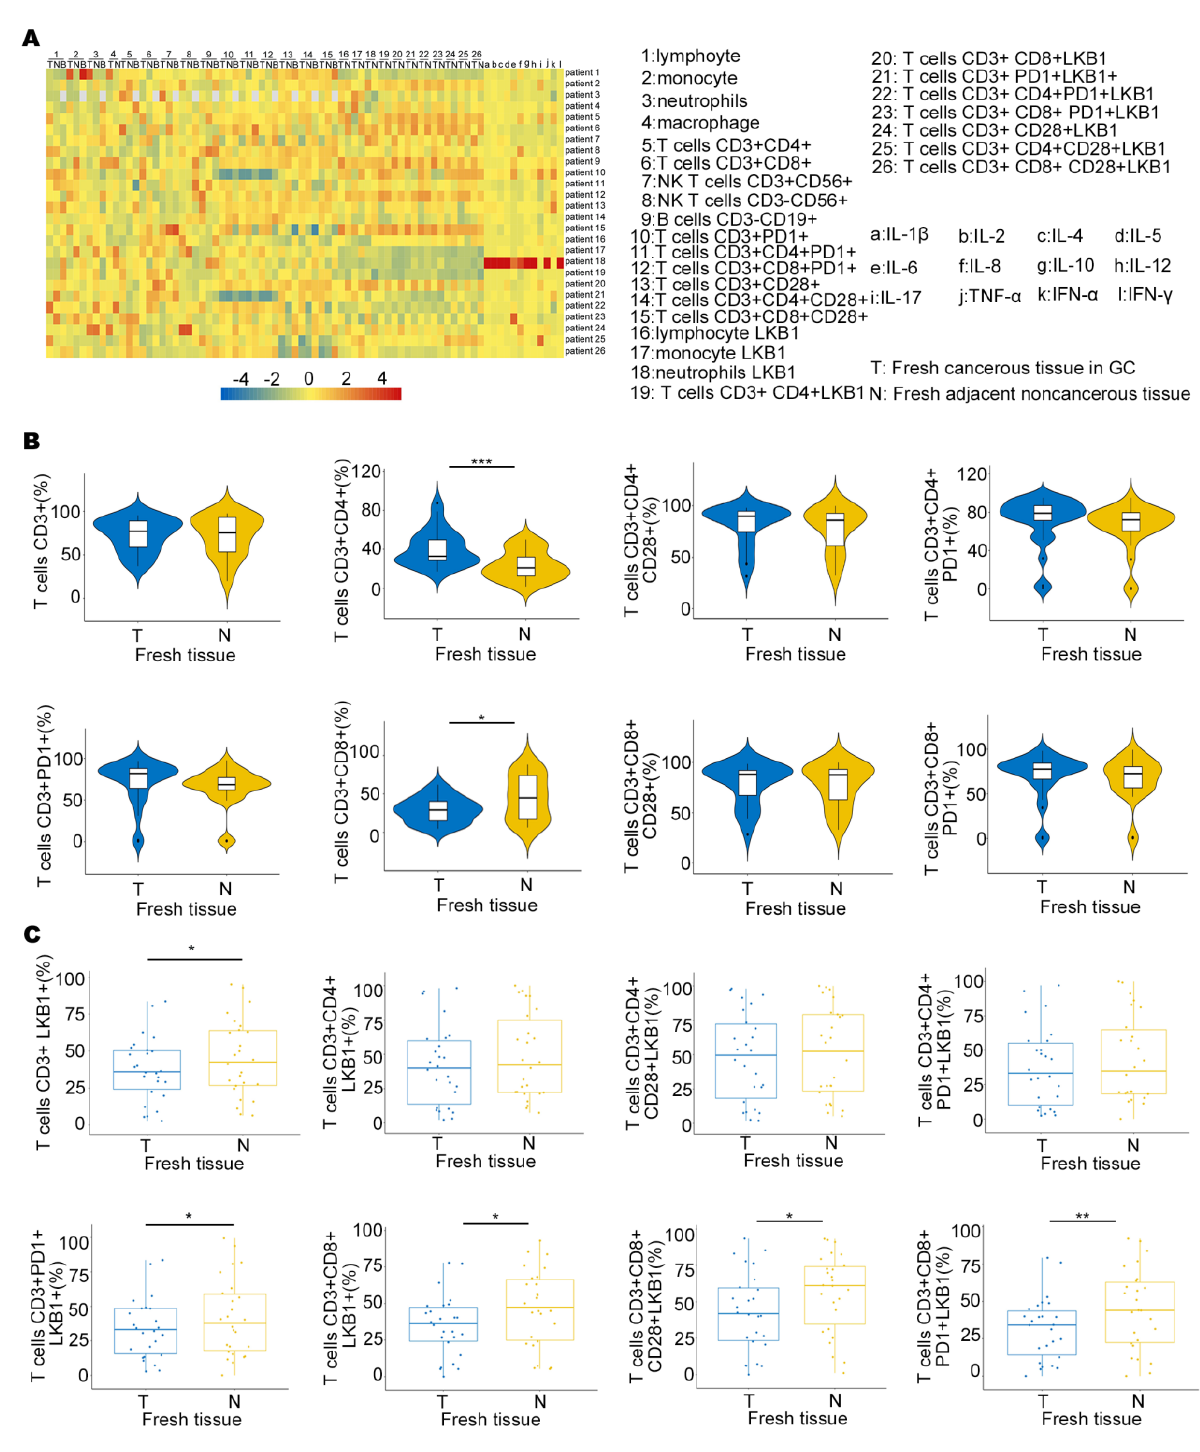
Figure 3. LKB1 is associated with T cell infiltration in GC patients. ( A ) The heatmap showing the immune cell proportion in peripheral blood ( B ), fresh cancerous (T) and adjacent non − cancerous tissues (N), and cytokine expression. ( B ) The ratios of different kinds of T cells in fresh cancerous (T) and adjacent non − cancerous tissues (N). ( C ) Differential proportions of T cells expressing LKB1 in fresh cancerous (T) and adjacent non − cancerous tissues (N). Paired t -test, * p < 0.05, ** p < 0.01, *** p < 0.001.